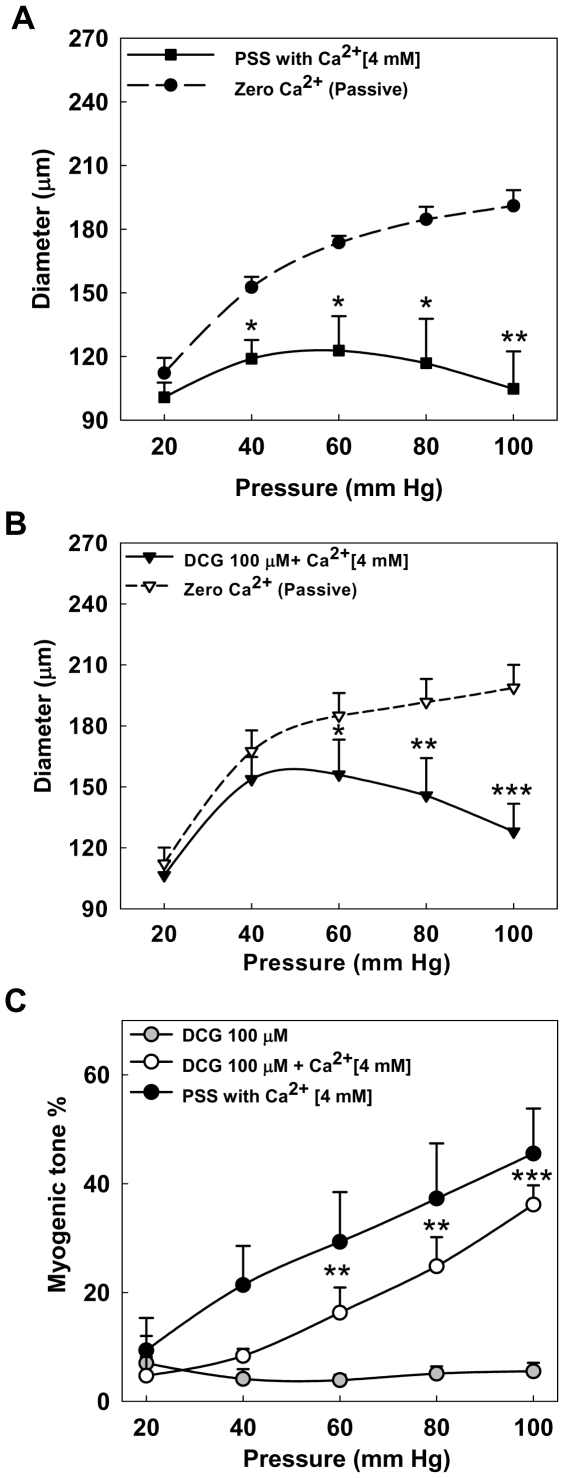
Effect Ca2+ (4 mM)-PSS on DCG-induced reduction of myogenic response.(A, B) To assess myogenic response, rat fourth-order mesenteric arteries were subjected to a series of intraluminal pressure steps between 20 and 100 mmHg in Ca2+(4 mM)-PSS alone or with 100 µM DCG. Spontaneous tone was allowed to develop until a stable diameter was achieved (solid line). The pressure-response was repeated in Ca2+-free PSS with 3 mM EGTA and 0.01 mM diltiazem (dashed line). Asterisks indicate significant differences between the diameters at each pressure step. (C) Summary data. MT was calculated as the percent difference in diameter observed for Ca2+ (4 mM)-containing vs. Ca2+-free PSS at each pressure. The bottom myogenic response curve for DCG (100 µM) in normal PSS is derived from Figure 4. Incubation of arteries with DCG (100 µM) in Ca2+ (4 mM)-PSS attenuated the DCG-induced reduction of myogenic response. Asterisks indicate significant difference in MT for the respective pressure step when compared to arteries incubated with DCG (100 µM) in normal PSS. (n = 4–7 arteries in each group).